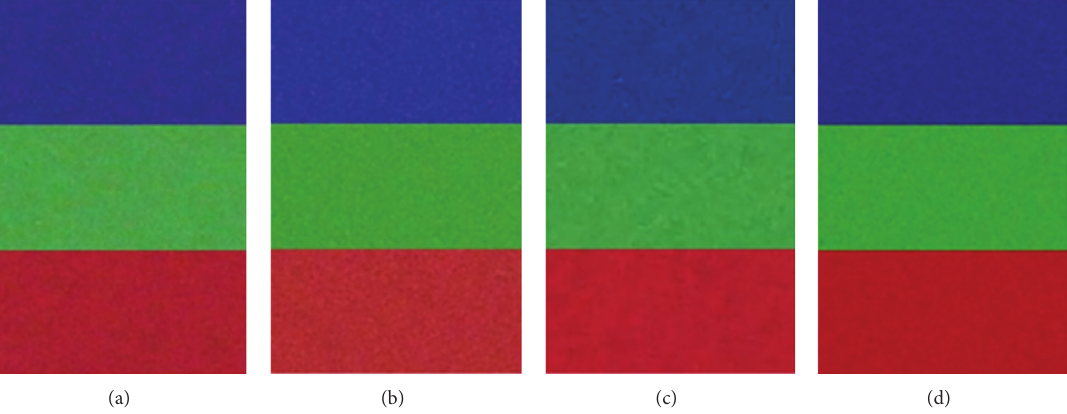
Figure 3: Visual noise comparison for pictures taken by different cameras under the same scenery with ISO = 1600: (a) Canon 550D, (b) Nikon D7000, (c) Sony A77, and (d) Pentax